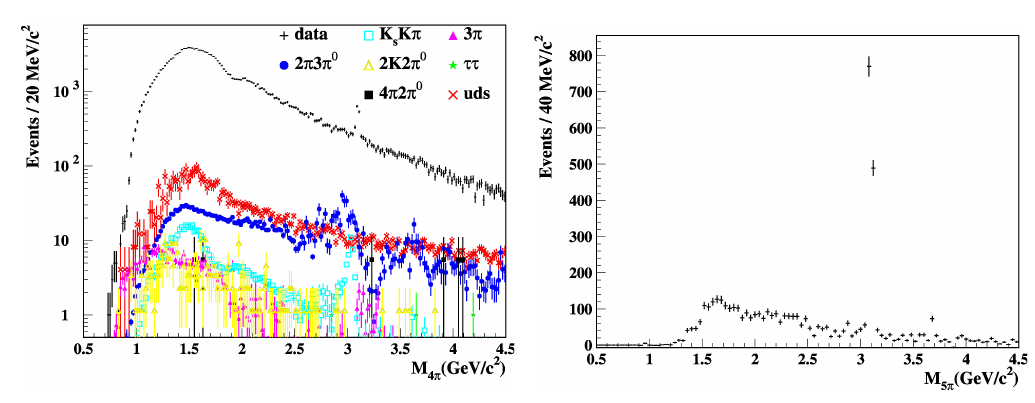
Figure 1: Contributions to the e + e − → π + π − 2 π 0 backgrounds [2].